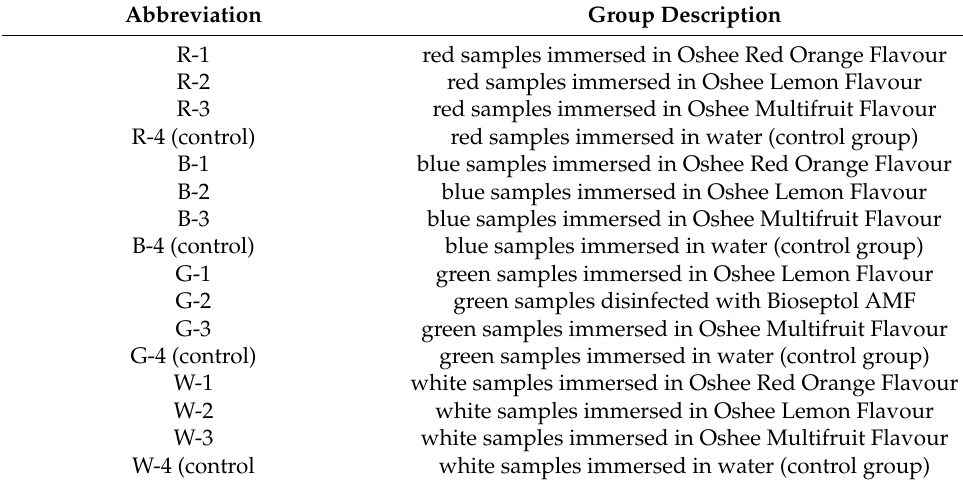
Table 3. Abbreviations for groups in isotonic drink